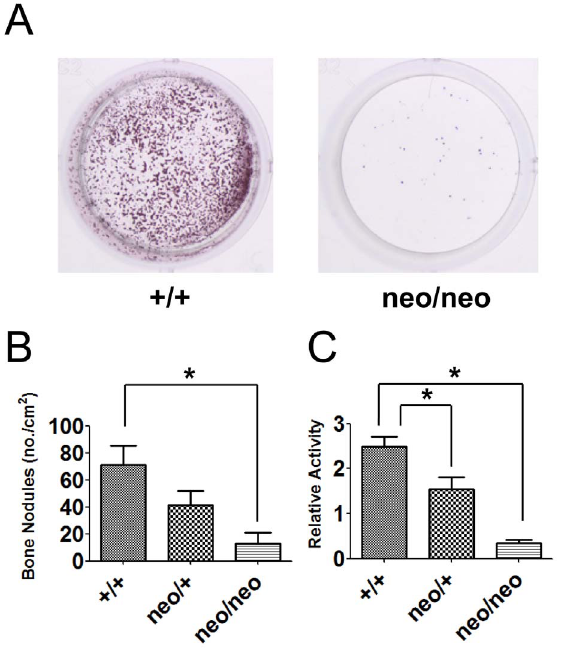
Figure 10. Calvarial cells of Runx2-I neo/neo mice showed defec- tive osteoblast development. Calvarial cells recovered from wild- type ( + / + ) and Runx2-I neo/neo (neo/neo) mice were cultured in osteogenic medium for 14 days and then fixed and stained with Alizarin red to visualize bone nodule formation. Stained culture wells (A) and numbers of bone nodules normalized by culture area (B). Data are means 6 SEM ( n =2–6/group); * p , 0.05. (C) At the same time that the Alizarin red assay was conducted, cells were lysed, and alkaline phosphatase activity was tested. Data are representative of four independent experiments and are means 6 SEM ( n =3–7/group); * p , 0.05.